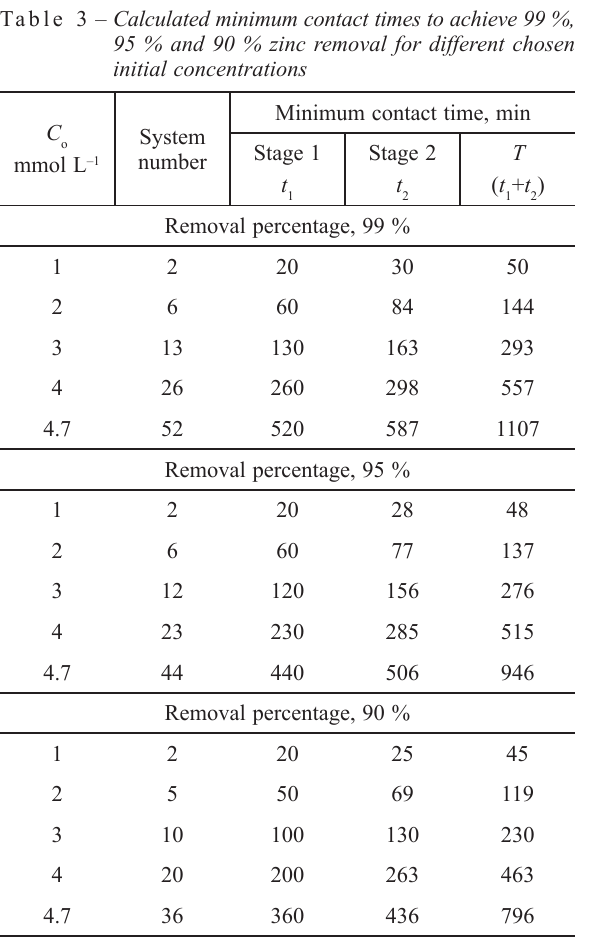
Table 4 – Calculated minimum contact times to achieve 99 %, 95 % and 90 % cadmium removal for different